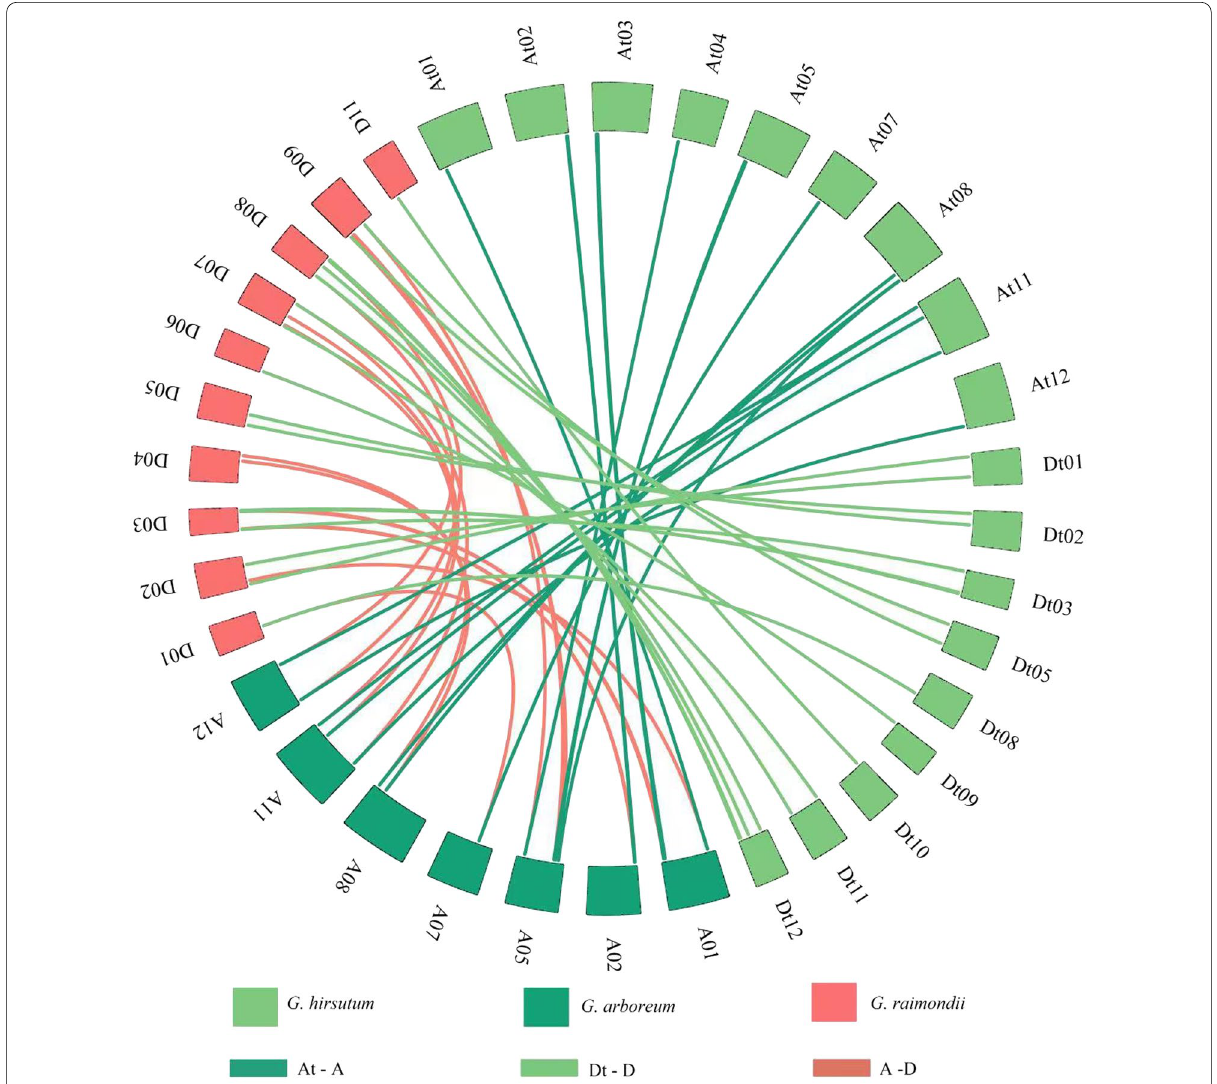
Fig. 2 Collinearity Analysis of MAPK genes in cotton. Dark green: G. arboreum ; Red: G. raimondii ; Light green: At and Dt of G.